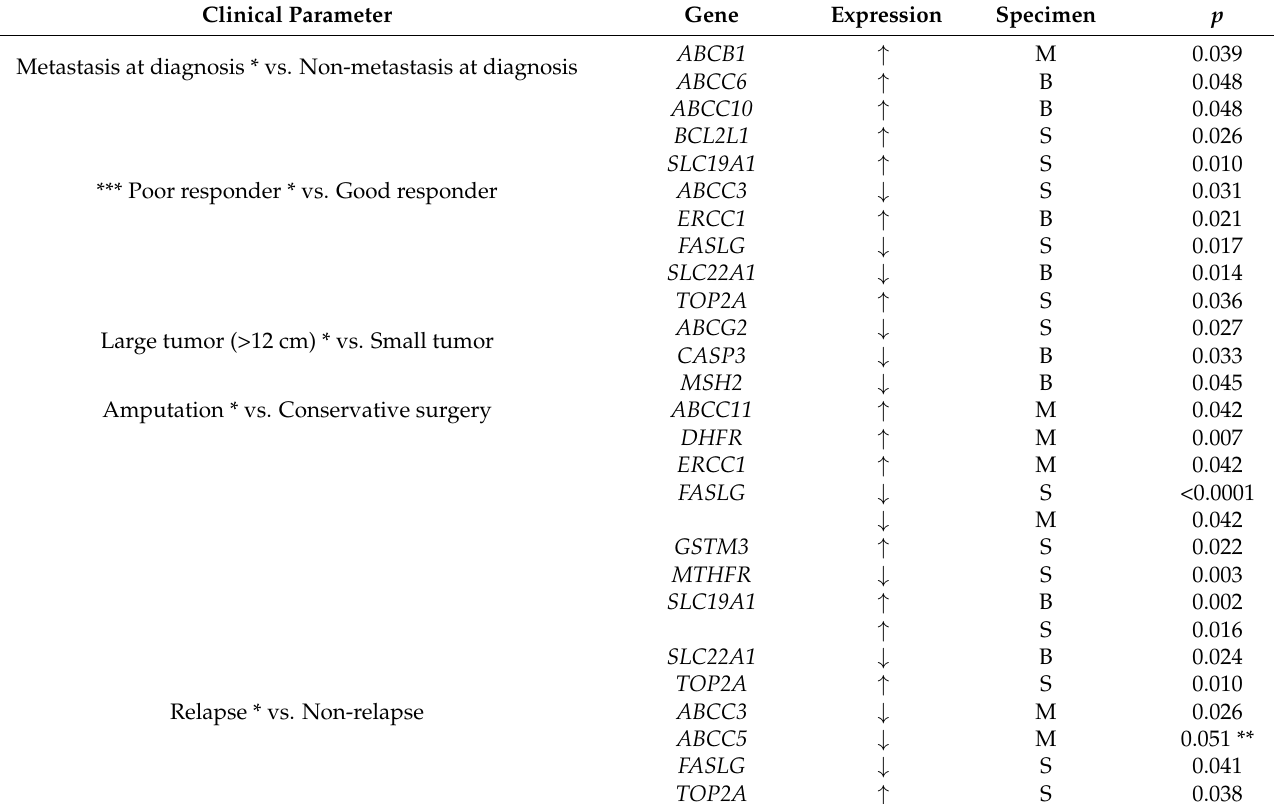
Table 1. Association between gene expression and clinical